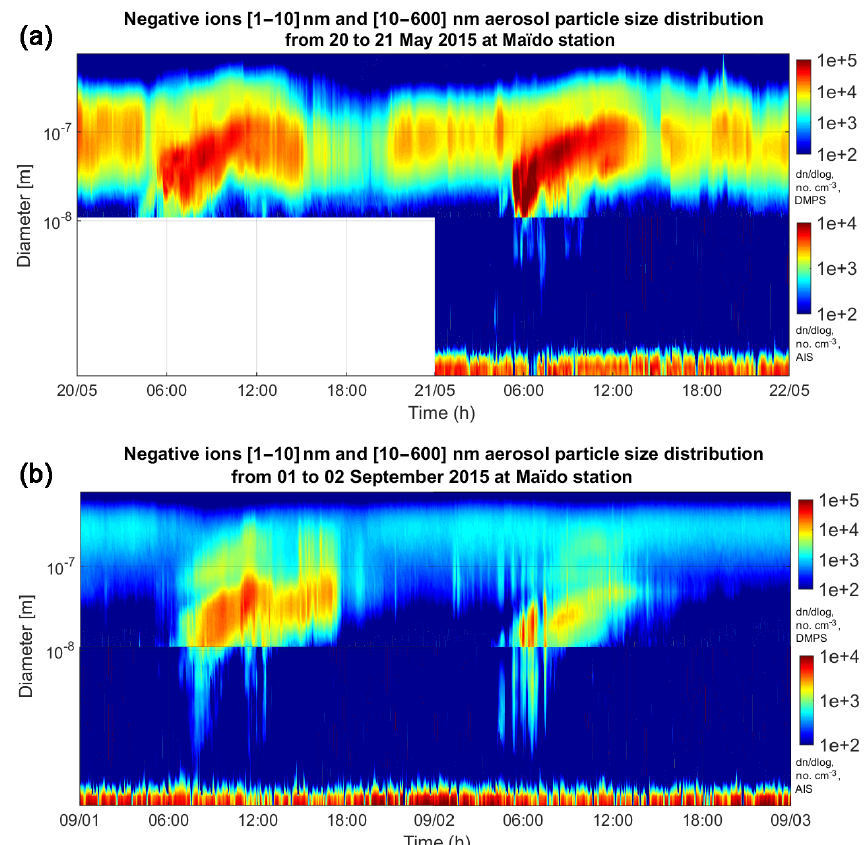
Figure 14. Negative ions (1–10nm) and (10–600nm) aerosol particle size distributions measured (a) on 20–21 May 2015 and (b) on 2– 3 September when the Piton de la Fournaise plume crossed the Maïdo station. No AIS data are available between 20 May at 00:00UTC and 21 May at 05:00UTC. Colour scale (right) indicates the ratio d N /d log in cm − 3